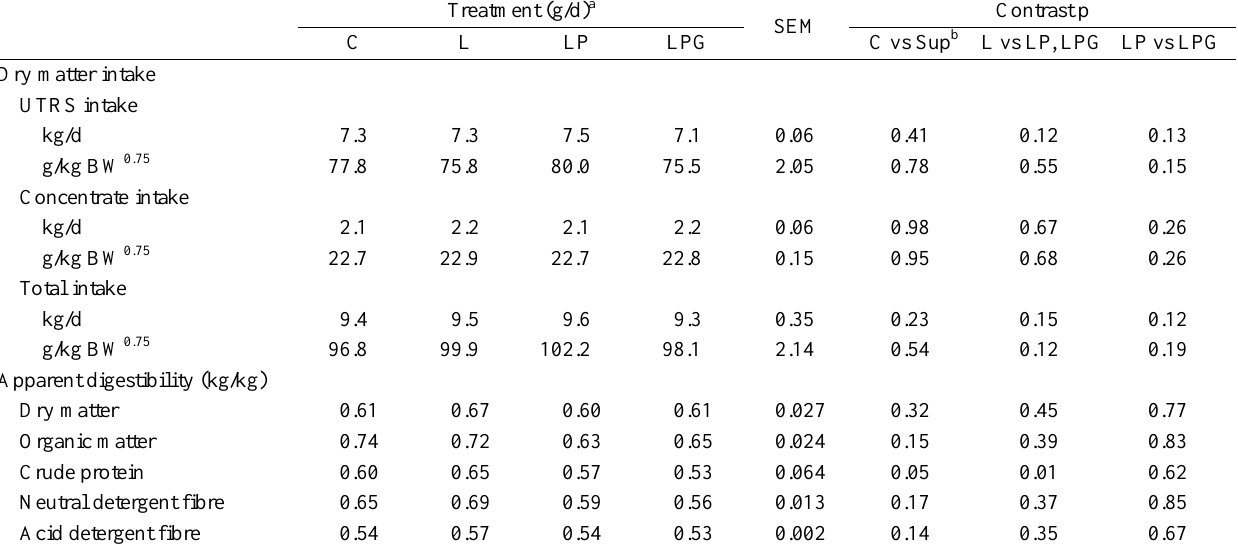
Table 4. Influence of lemongrass, peppermint and garlic supplementation on dry matter intake and apparent nutrient